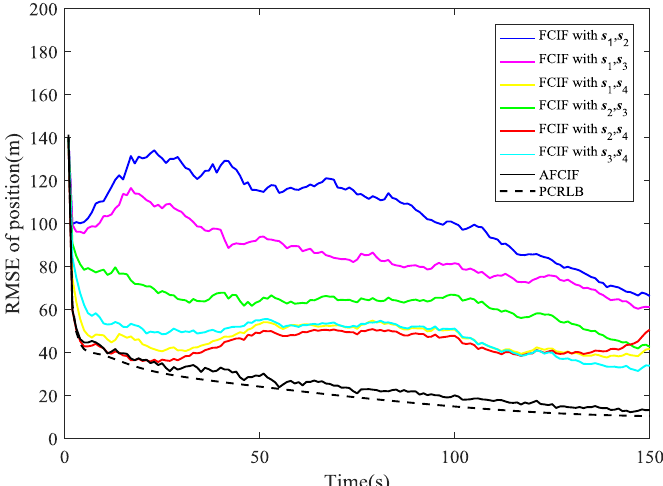
Figure 4. Comparison of RMSE (position estimation) when the initial process noise covariance is set to be smaller than the true value.